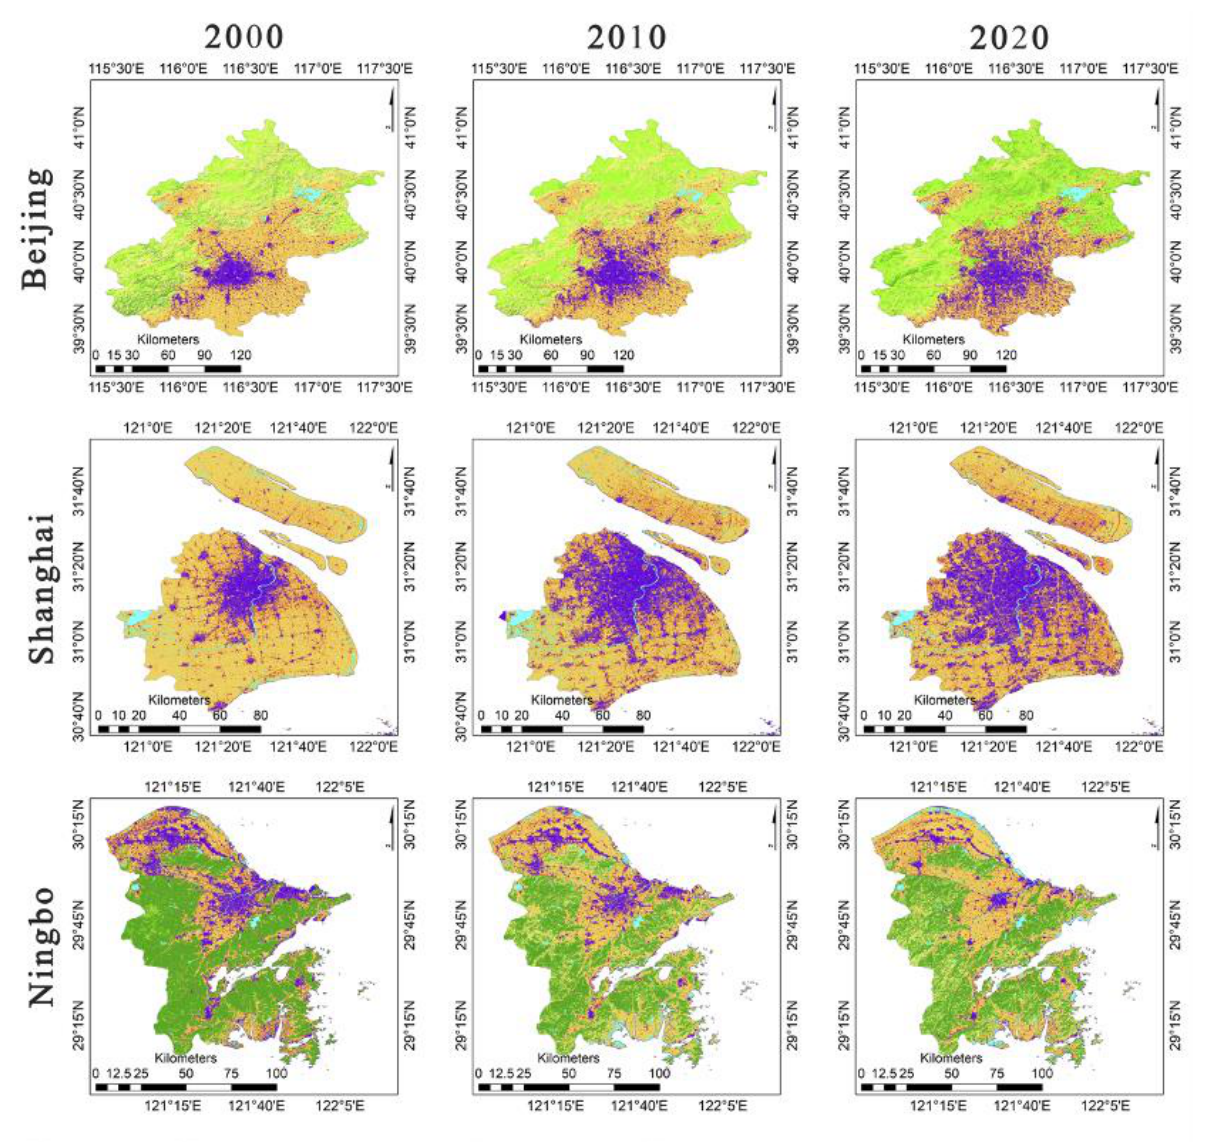
Figure 4. ( a ) Land cover map of the three European cities in 2000, 2010 and 2020 generated by the best-fit model and well-selected variables. ( b ) Land cover map of the three Chinese cities in 2000, 2010 and 2020 generated by the best-fit model and well-selected variables.